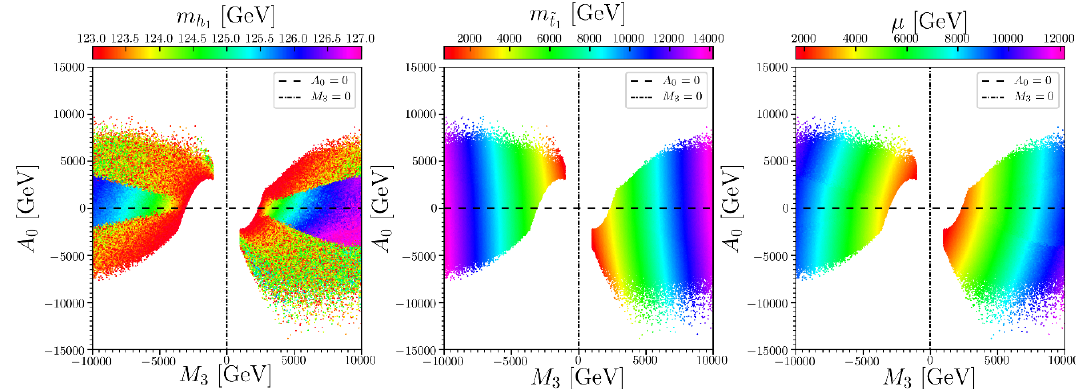
Figure 1 . Surviving samples in the A 0 versus M 3 planes, with colors indicating the lighter Higgs mass m h (left), lighter stop mass m ~ (middle) and higgsino mass parameter (cid:22) (right), respectively. t 1 In these 2-dimension planes, larger-(cid:1) a (cid:22) samples are projected on top of smaller